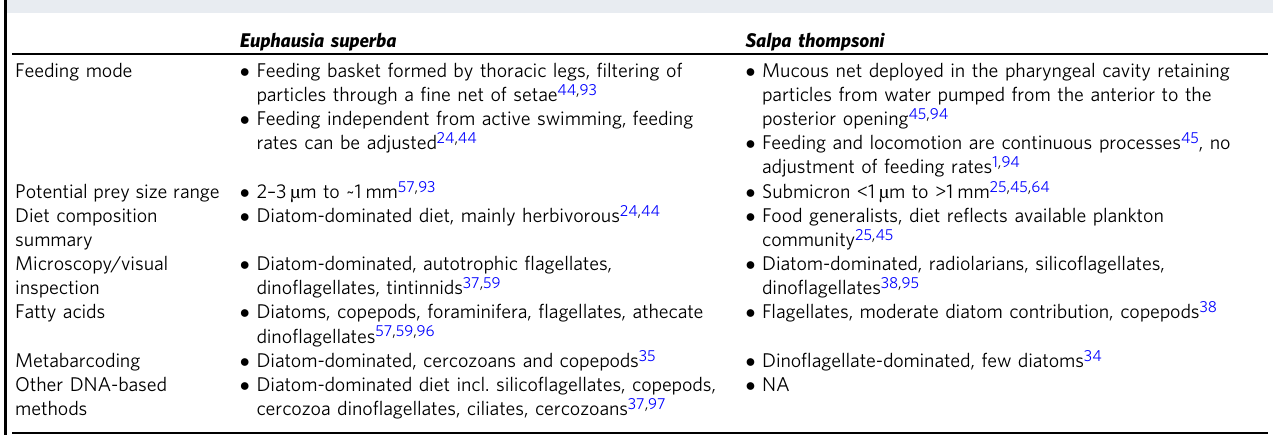
Table 1 Feeding modes and diet composition of krill and